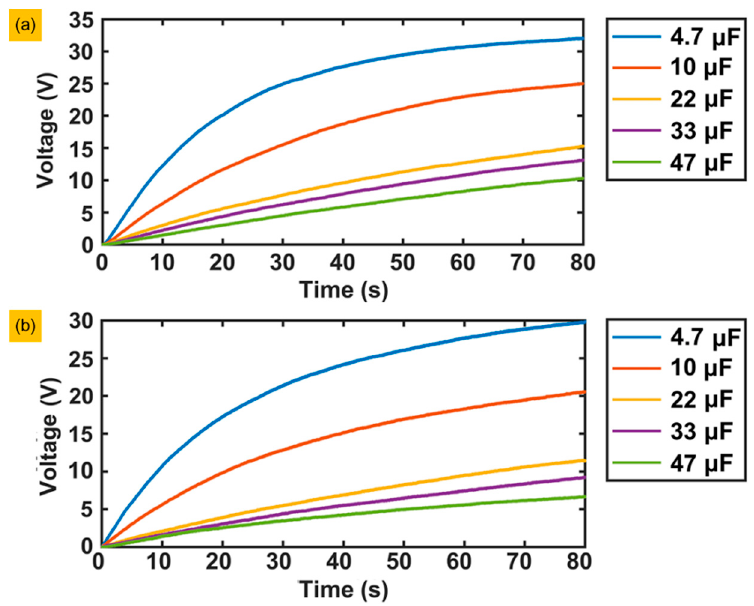
Figure 10. Experimental results of capacitor charging: ( a ). Series circuit. ( b ). The charging effect of only piezoelectric plate number 1.